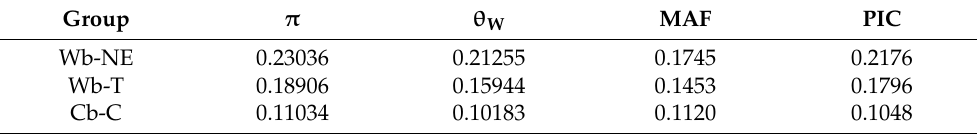
Table 1. Estimate of genetic diversity per base pair for three groups (Wb-NE, Wb-T, and Cb-C). Group π θ W MAF PIC Wb-NE